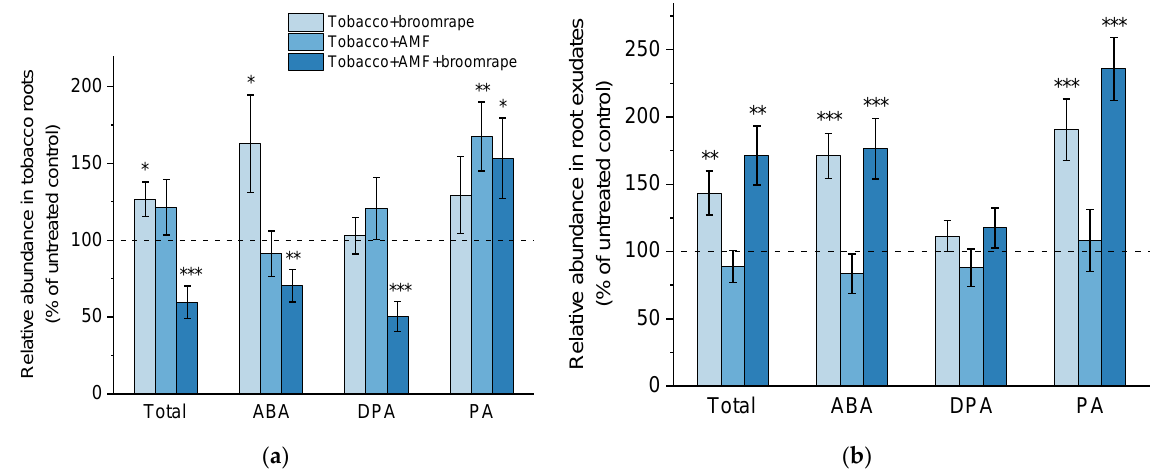
Figure 1. Levels of abscisic acid (ABA) and its catabolites dihydrophaseic acid (DPA) and phaseic acid (PA) in roots ( a ) and exudates ( b ) of tobacco plants upon broomrape infestation and/or colonization with arbuscular mycorrhizal fungi (AMF). The total ABA content represents the sum of all detected ABA-related metabolites in roots and root exudates, respectively (see Section 2.1.1). Values are relative to the non-infested and non-inoculated control (dashed line), and are means of four biological repeats (i.e., independent experiments), with three plants per variant analyzed within each repeat. Error bars indicate standard error of the mean (SE). *** p < 0.001, ** p < 0.01, and * p < 0.05 (Student’s t -test).